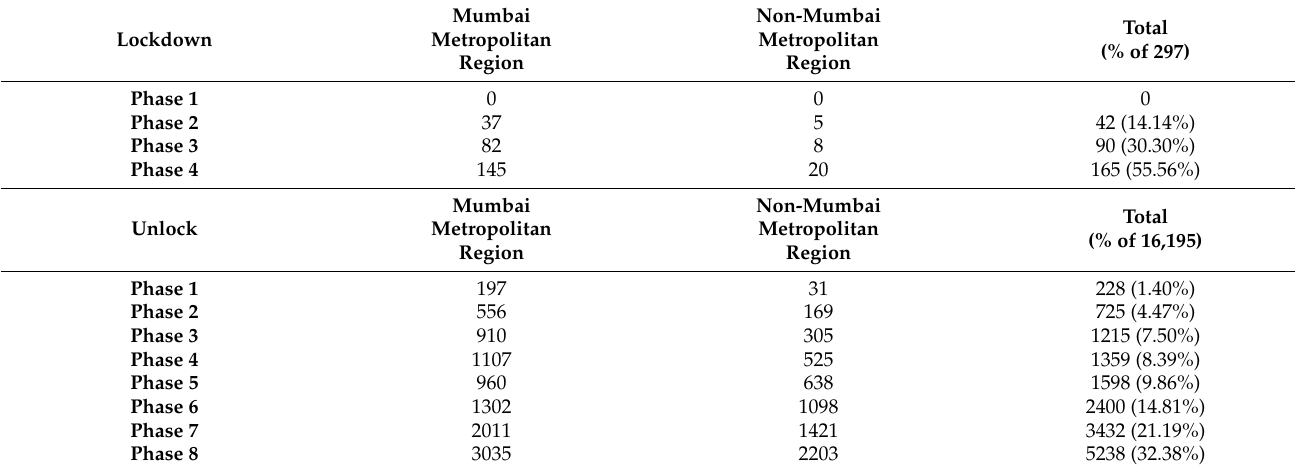
Table 6. Number of patients that visited the dental school from the Mumbai metropolitan region and non-Mumbai metropolitan region during lockdown and unlock